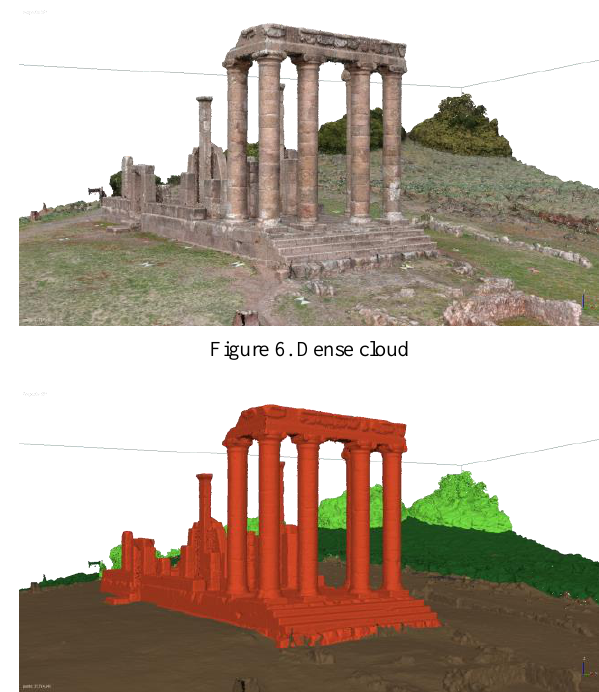
Figure 7. Dense cloud classification